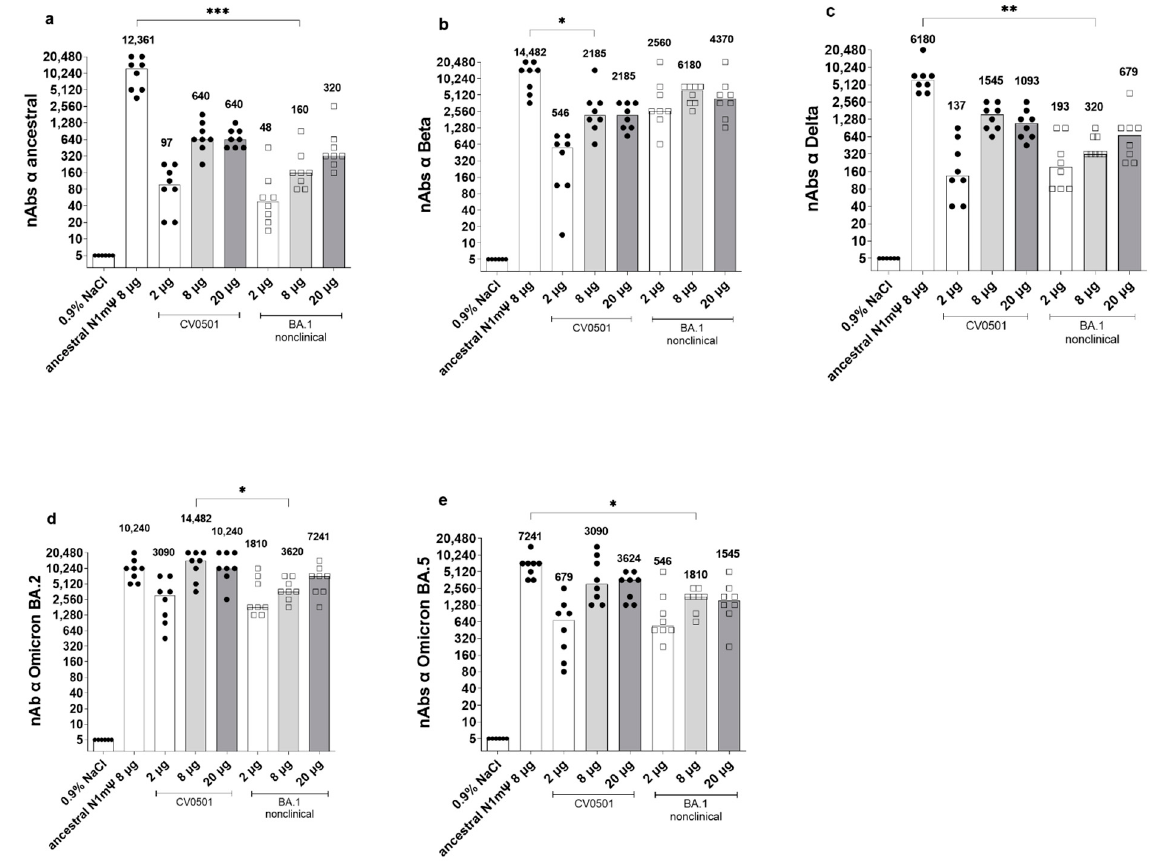
Figure 2. CV0501 and BA.1 nonclinical preferentially induce cross nAbs towards the Omicron subvariants. Wistar rats ( n = 8/group) were immunized on Days 0 and 21 with 2, 8 or 20 µg CV0501 (circles) or BA.1 nonclinical (squares), 8 µg of ancestral N1m Ψ (triangles), or 0.9% NaCl (control, n = 6). nAbs against the ancestral ( a ), Beta ( b ), Delta ( c ), BA.2 ( d ) and BA.5 ( e ) SARS-CoV-2 variants were assessed from serum taken on Day 42 post immunization. The symbols represent individual animals and the bars the median (median values are indicated as number above each bar). Statistical analyses were performed via pair-wise comparisons between ancestral N1m Ψ , 8 µg CV0501 and 8 µg BA.1 nonclinical using ANOVA and Kruskal-Wallis test. Only significant results are indicated. * p < 0.05, ** p < 0.01, *** p < 0.001.